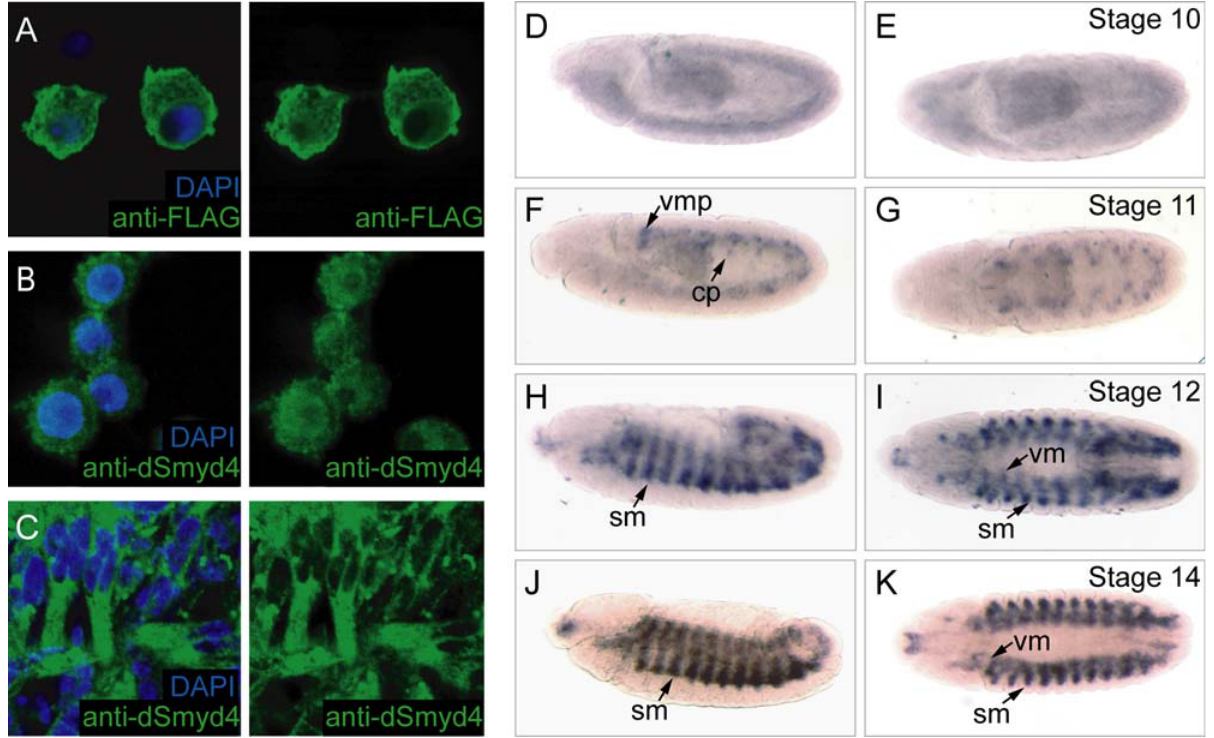
Figure 4. dSmyd4 is expressed in the embryonic mesoderm. A, dSmyd4-FLAG was over-expressed in S2 cells and visualised by immunofluorescence using anti-FLAG. B, Endogenous dSmyd4 in S2 cells was visualised by immunofluorescence using anti-dSmyd4. C, Endogenous dSmyd4 in late stage Drosophila embryos was visualised by immunofluorescence using anti-dSmyd4. In A, B and C, nuclei were visualised with 4 9 ,6- diamidino-2-phenylindole (DAPI). D–K, In situ hybridisation of dSmyd4 mRNA in developing Drosophila embryos, anterior to the left. D, F, H and J are lateral views; E, G, I and K are dorsal views. D and E, stage 10 embryo, weak expression of dSmyd4 throughout the mesoderm. F and G, stage 11 embryo, dSmyd4 expression in specified mesoderm. vmp, visceral muscle precursor; cp, cardiac precursor. H and I, stage 12 embryo, dSmyd4 was expressed at high levels in the somatic muscle (sm) and expression was maintained in visceral muscle (vm). J and K, stage 14 embryo.